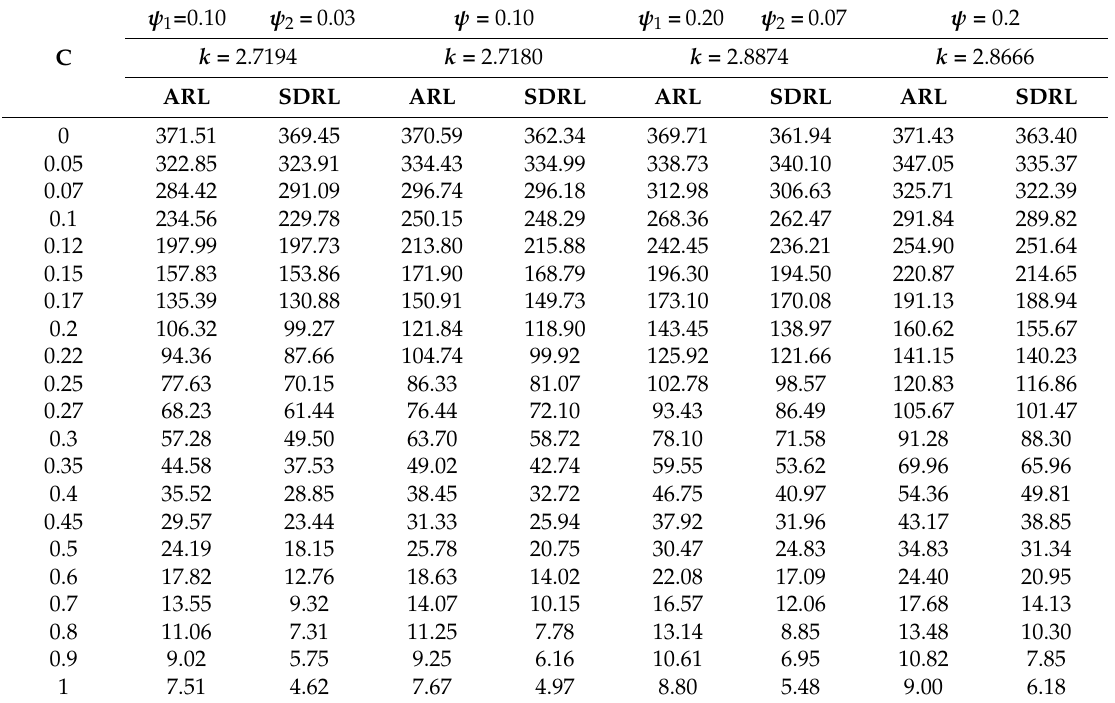
Table 3. The ARL, SDRL values of the proposed EEWMA and EWMA control charts for various shifts when r 0 =